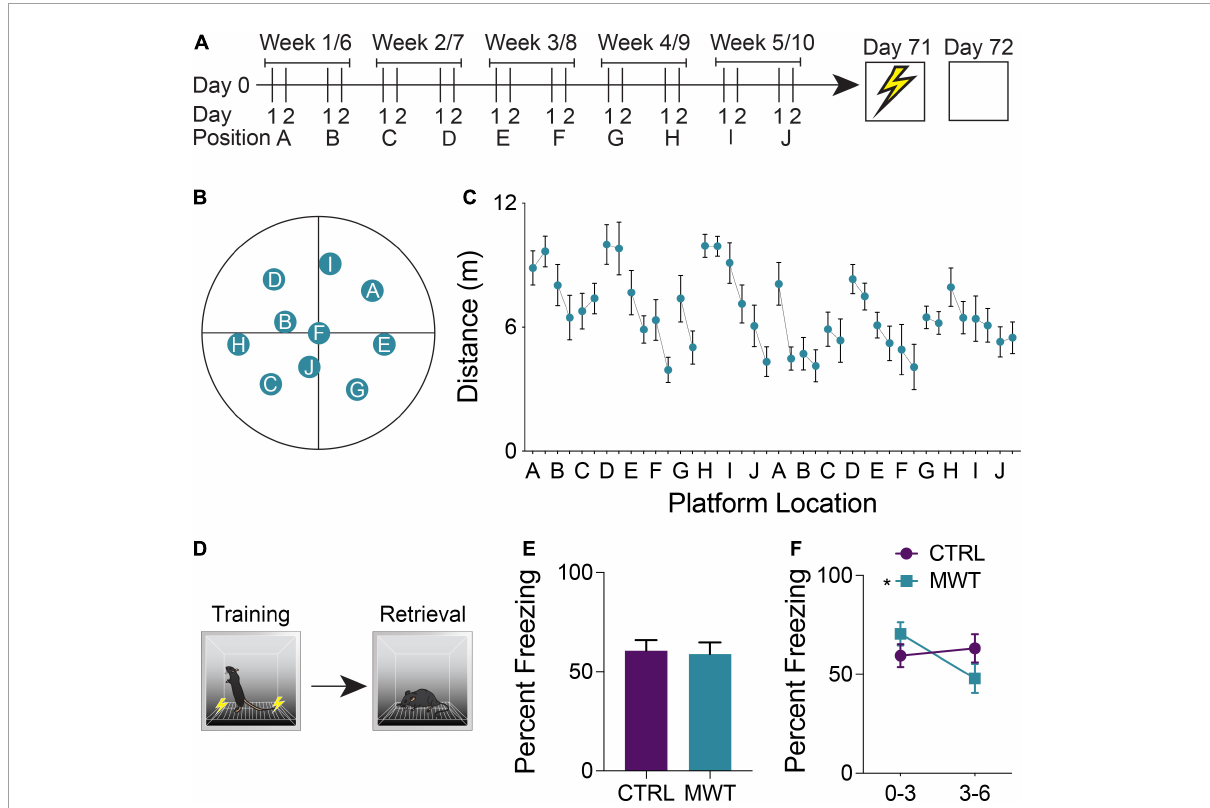
FIGURE1 (A) Mice were trained on a repeated acquisition and performance testing variation of the MWM ( n = 10) or kept in conventional housing conditions ( n = 10) for 10 weeks. Afterward all mice underwent contextual fear conditioning and a retention test 24 h later. (B) During water maze training, the escape platform was moved every second day between 10 locations. After the 10 th position, the platform was returned to the 1st position and the cycle was restarted. (C) Mean distance traveled in the water maze across each of the 20 locations. (D) During contextual fear memory retrieval, (E) there was no overall difference in freezing rates between the control group and the group which had underwent Morris Water Maze training (Paired two-tailed t test; P > 0.05). (F) Mice who had underwent Morris Water Maze training froze significantly more during the first half (minutes 0-3) of the test than they did during the second half of the test (minutes 3-6; Two-Way Repeated Measures ANOVA; Time × Treatment interaction: F 1 , 18 = 7.763, p = 0.0122; MWM 0-3 – 3–6: p < 0.0066), while control mice showed no difference in task performance across these two halves of the test. Data shown are mean ± SEM when